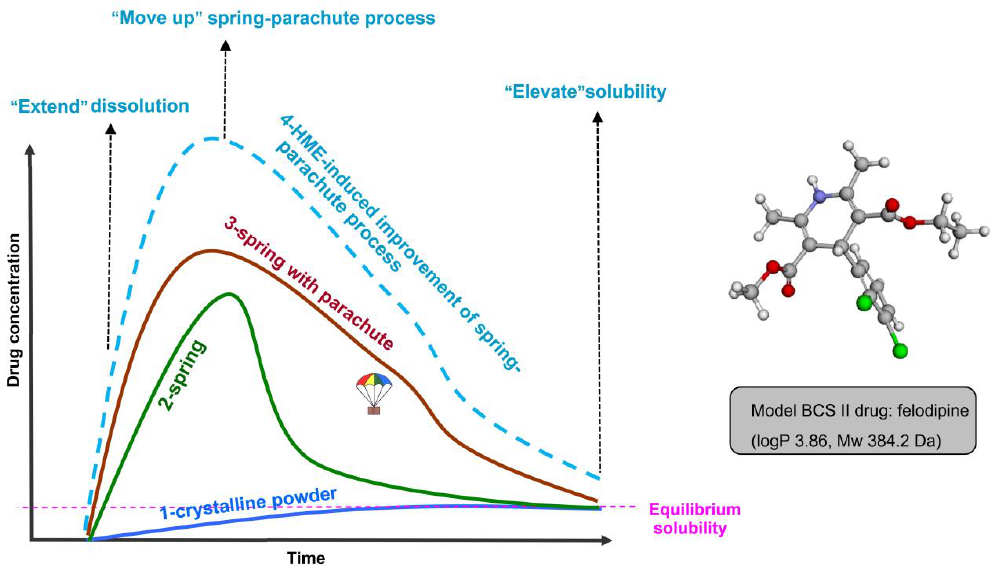
Figure 11. Illustration showing HME-induced improvement of supersaturable immediate-release at initial/evolved/terminal three-stage in faSDDS HME systems containing the model BCS II drug, felodi- pine: 1 crystalline powder; 2 spring process without parachute process induced by pure amorphous drug; 3 spring-parachute process induced by amorphous faSDDS approach; 4 HME-induced im- provement of spring-parachute process of faSDDS systems.